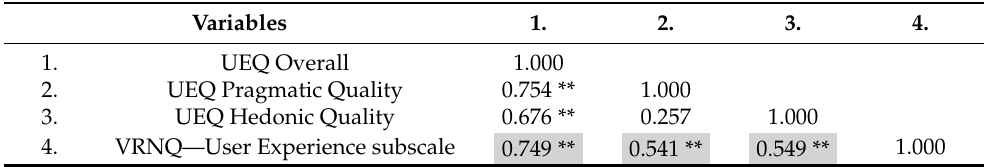
Table 18. Correlation matrix for HA_RFH condition—Spearman ( ρ ) correlation coefficients for combined user experience measures ( n = 4).